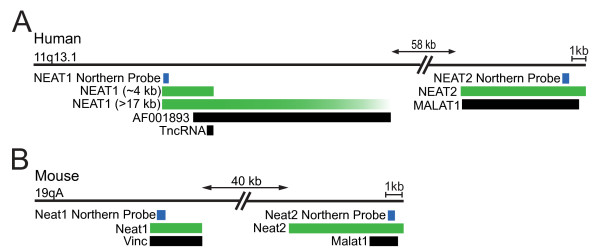
Genomic Organization of the Human and Mouse NEAT1 and NEAT2 Loci. (A, B) Graphical representation of locations and lengths of transcripts and probes mapping to the genomic region of (A) human NEAT1/NEAT2 on 11q13.1 and (B) mouse Neat1/Neat2 on 19qA. All transcripts run 5' to 3' from left to right. Transcripts represented in green (NEAT1, NEAT2, Neat1 and Neat2) were characterized by Northern analysis, 5'RLM-RACE and 3' RACE. Genbank accession number for these transcripts are: NEAT1 – EF177379, NEAT2 – EF177381, Neat1 – EF177378 and Neat2 – EF177380. For these transcripts, all 3' poly(A) ends had a consensus AAUAAA 10–30 nucleotides 5' of the poly(A) site and a GU rich and/or U rich element 3' of the site. Human NEAT1 is observed to extend past its primary poly(A) site, resulting in a larger, >17 kb transcript. The 3' end of this larger transcript is drawn fading to represent that while its location is suggested by AF001893 (Guru et al., 1997) and our own Northern analyses (data not shown), we were unable to fully map its 3' end by RACE, most likely due to a series of genomic poly(A) repeats throughout the transcript. Transcripts in black were previously described to various levels by EST walking, Northern and RACE analysis. Probes used in our Northern analyses (Figure 3) are represented in blue.